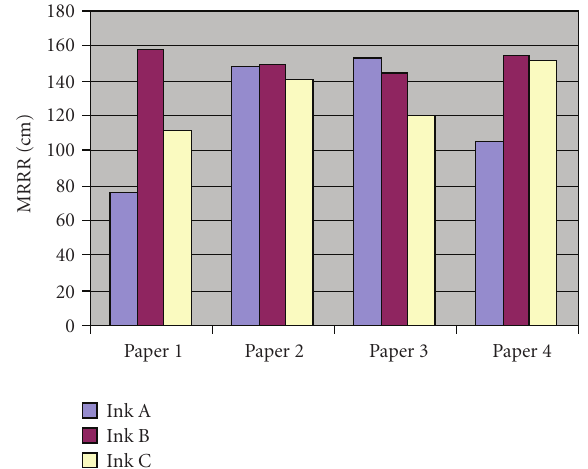
Figure 5: The average MRRR values, linearly polarized reader an-